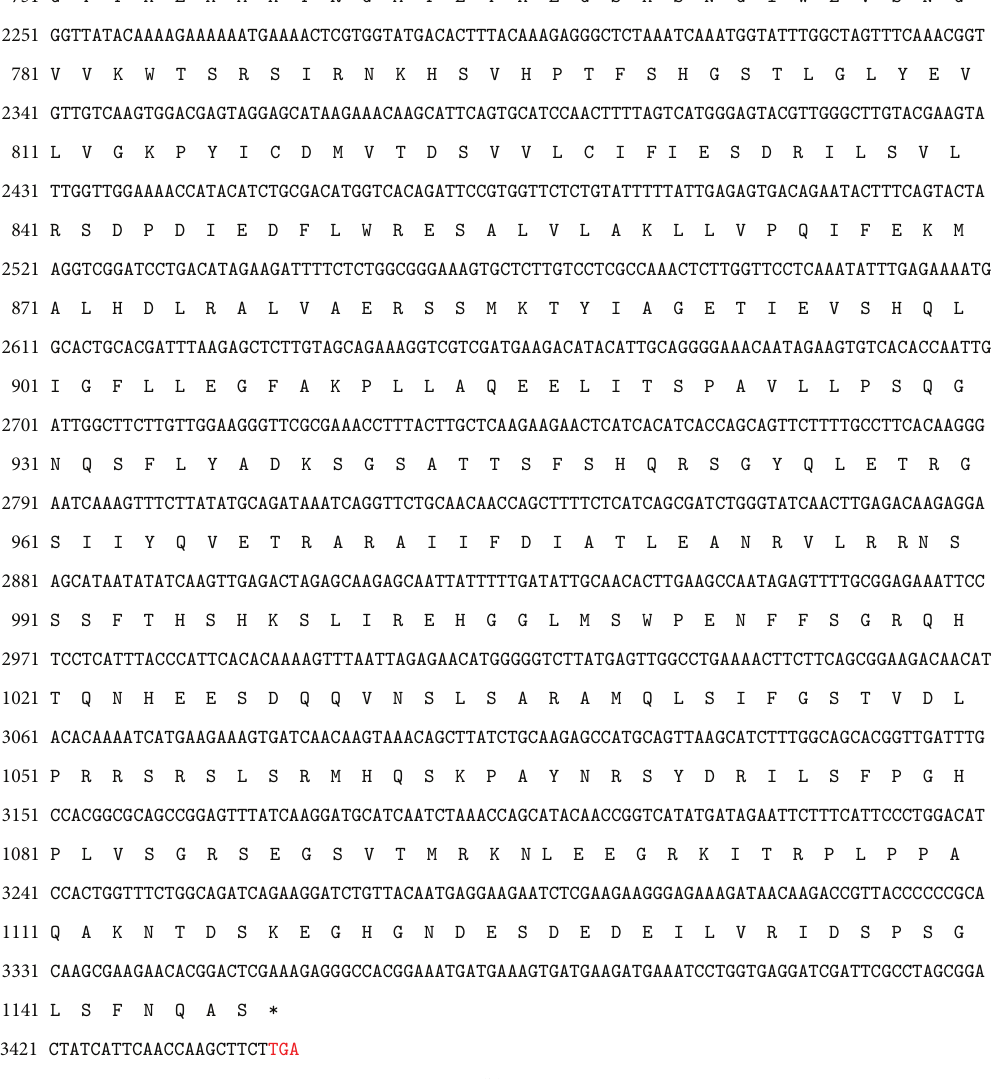
Figure 5: The ORF nucleotide sequence and the deduced peptide sequence of KvSOS1 . Start codon and termination codon are highlighted in